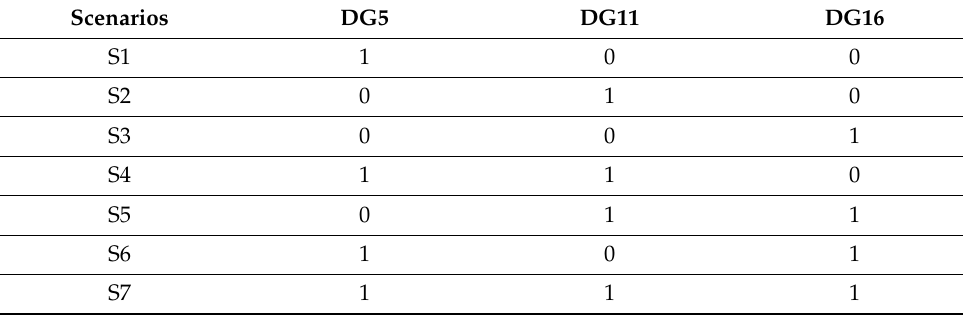
Table 3. Multi-DG configuration scenarios.